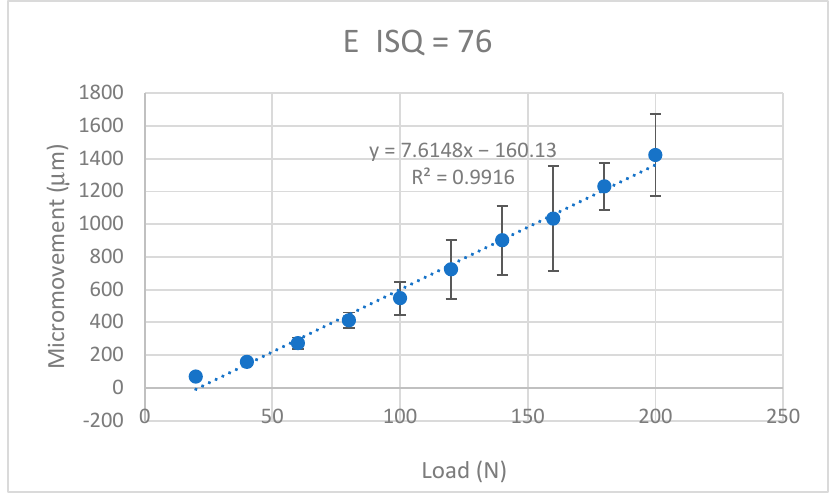
Figure 11. Micromovements in micrometers associated with the load in N for the E implants.